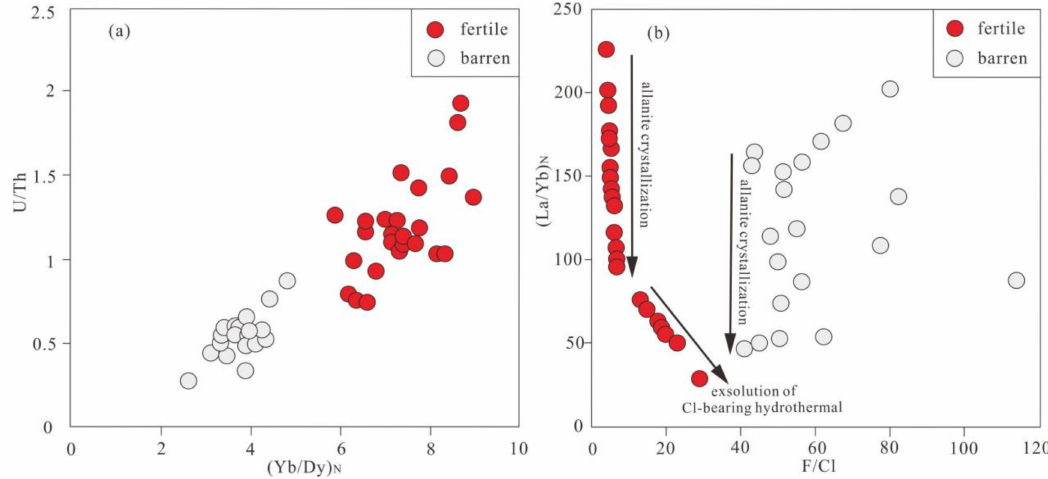
Figure 8. ( a ) Plots of U/Th vs. (Yb/Dy) N in zircon [76]; ( b ) Plot of (La/Yb) N vs. F/Cl in apatite [7].